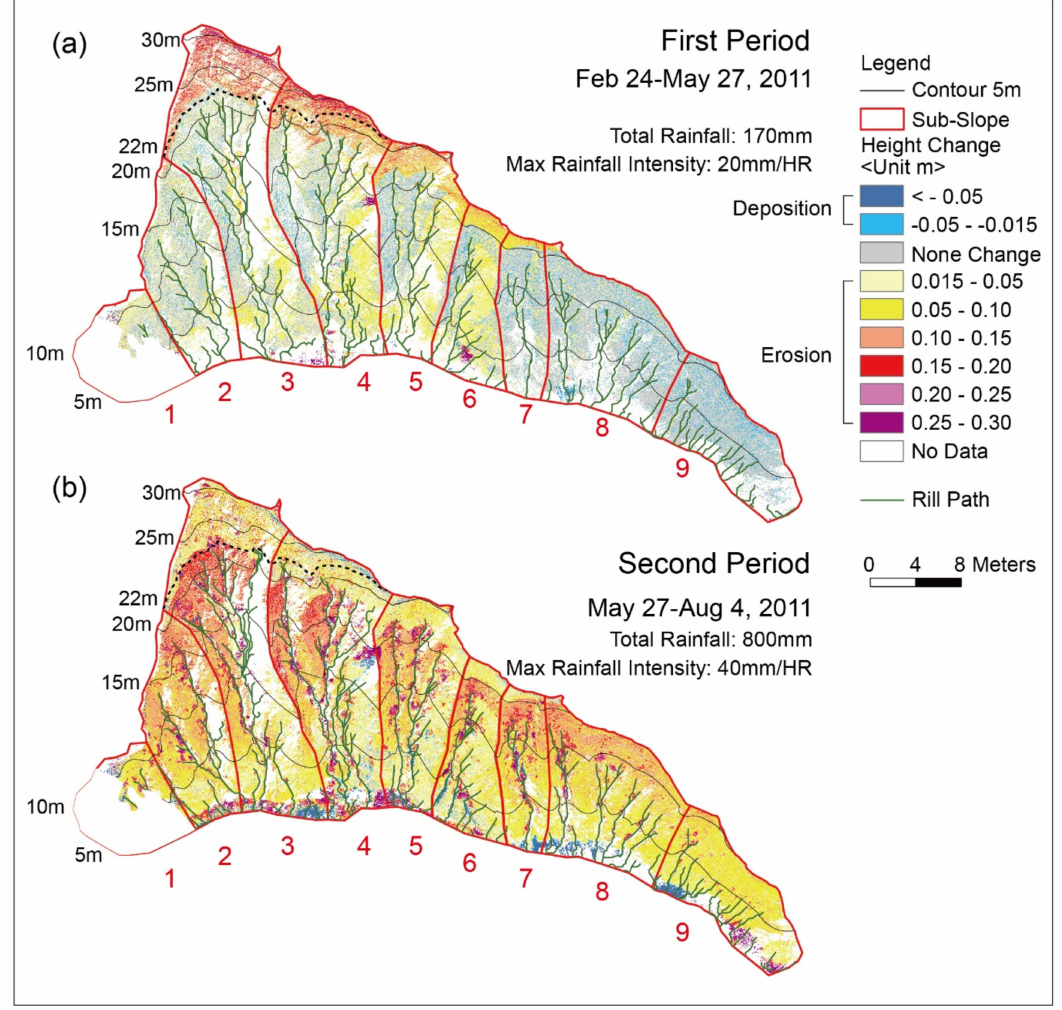
Figure 6. Erosion pattern in the first period ( a ) and second period ( b ) in